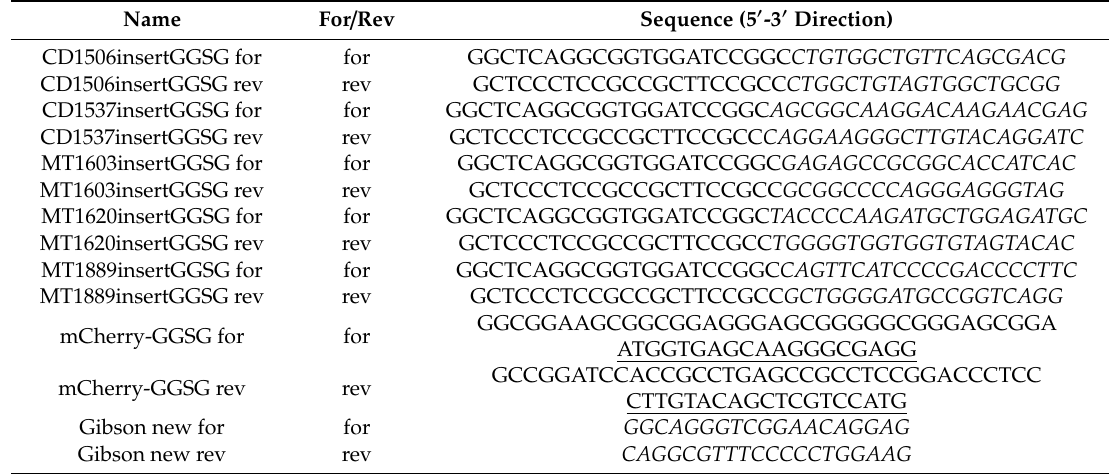
Table 1. L-expressionplasmidcloningstrategyprimer. italics—Lsequence; underline—mCherrysequence.